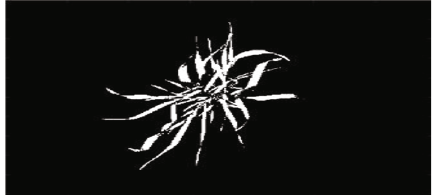
Figure 4: Segmentation algorithm used: Global Static Thresholding ( fi xed value); description: some pixel values lost membership in the fi nal segmented image.